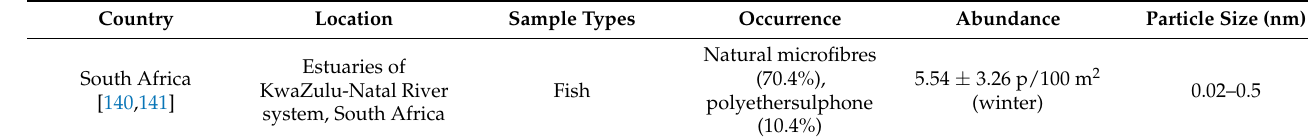
Table 2. Microplastics in African aquatic